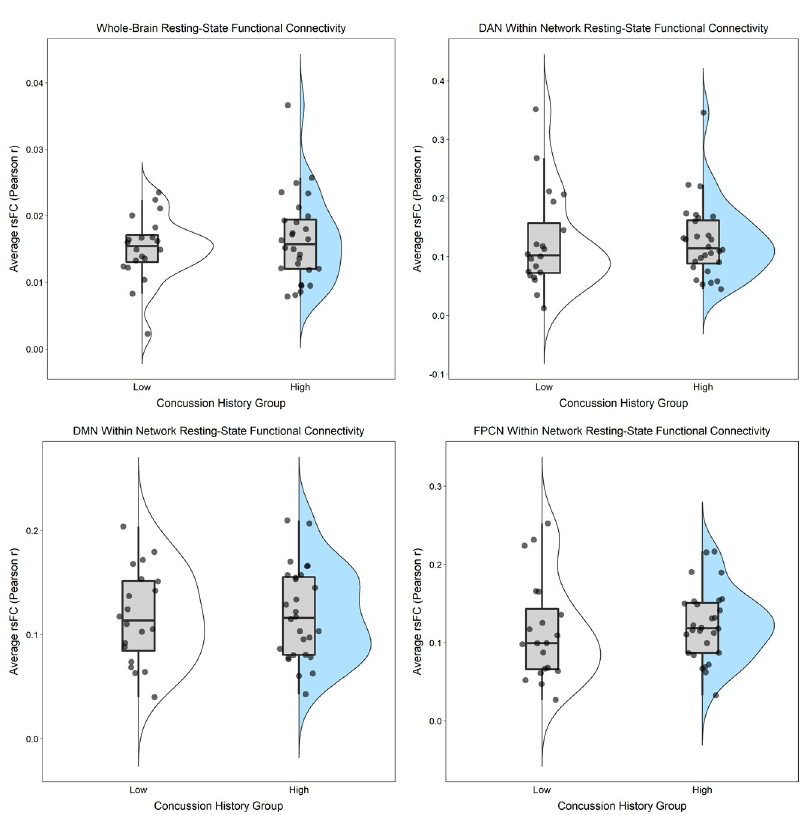
Fig 1. Whole-brain and within-network resting-state functional connectivity (rsFC) in large-scale networks separated by dichotomous concussion history group. Whole-brain rsFC (top-left) was calculated as the average Pearson r correlation (y-axes) between each of the 300 regions of interest (ROIs) and all other ROIs across the time- series. Within-network rsFC for the Dorsal Attention Network (DAN; top-right), the Default Mode Network (DMN; bottom-left), and the Frontoparietal Control Network (FPCN; bottom-right) was calculated as the average Pearson r correlation between each of the individual ROIs from the given network and all other ROIs within that same network across the time-series. Individual points represent participant-level outcomes for each measure within each of the concussion history groups (White = “Low” [fewer than 3 lifetime concussions]; Blue =“High” [3 or more lifetime concussions]). Boxplots represent the median and interquartile range, and the whiskers extend to 1.5 times the interquartile range. The violin plot is a depiction of the density of individual rsFC values for each